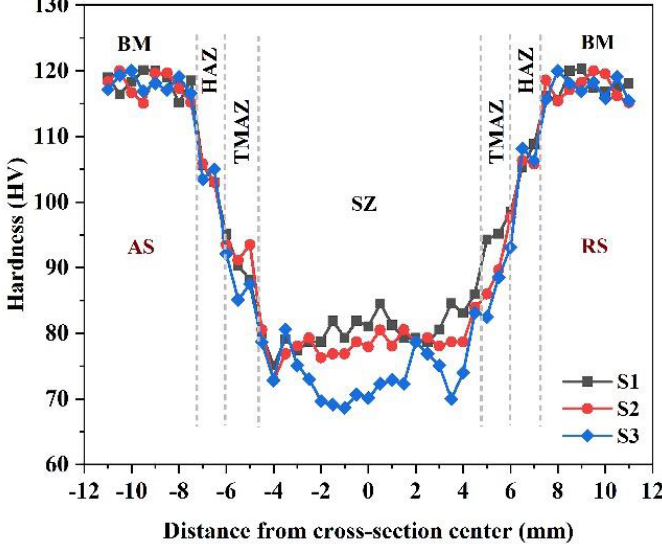
Figure 15. Hardness profiles of BM and different FSPed samples.